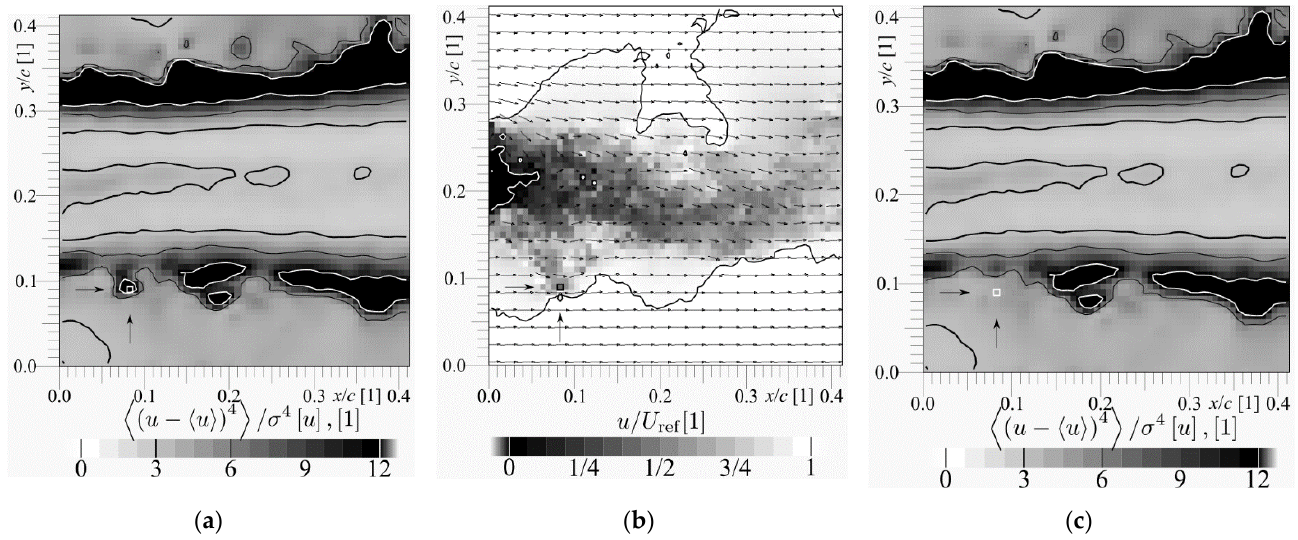
Figure 9. ( a ) Spatial distribution of stream-wise velocity flatness; the thick isoline refers to value of 3, the thin black isoline to 6, the white isoline to values greater than 12. ( b ) The instantaneous velocity field with value most different from the average in the point denoted by rectangle and a pair of arrows in bottom left corner. Note that this snapshot is a regular case, it is not noisier than the others, however there is some fluid of lower velocity ejected from the wake into the surroundings hitting the denoted point. ( c ) Spatial distribution of flatness of the ensemble without the snapshot ( b ). Note that removal of single case of 1208 significantly decreases the flatness signal in the denoted point.